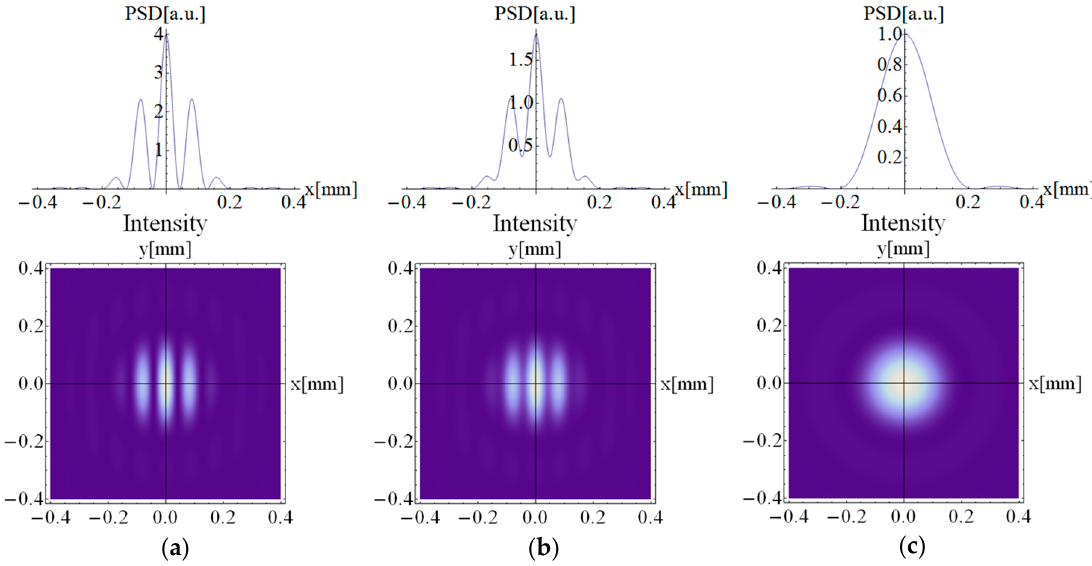
Figure4. Simulationresultsofthedistributionofthepowerspectraldensity(PSD)andthecorresponding Figure 4. Simulation results of the distribution of the power spectral density (PSD) and the interferograms of the fringe patterns for a di ff erent polarization orientation di ff erence ( θ ) between the corresponding interferograms of the fringe patterns for a different polarization orientation difference interfering beams: ( a ) θ = 0 ◦ , ( b ) θ = 70 ◦ , and ( c ) θ = 90 ◦ ( θ) between the interfering beams: ( a ) θ = 0°, ( b ) θ =70°, and ( c ) θ = 90°.